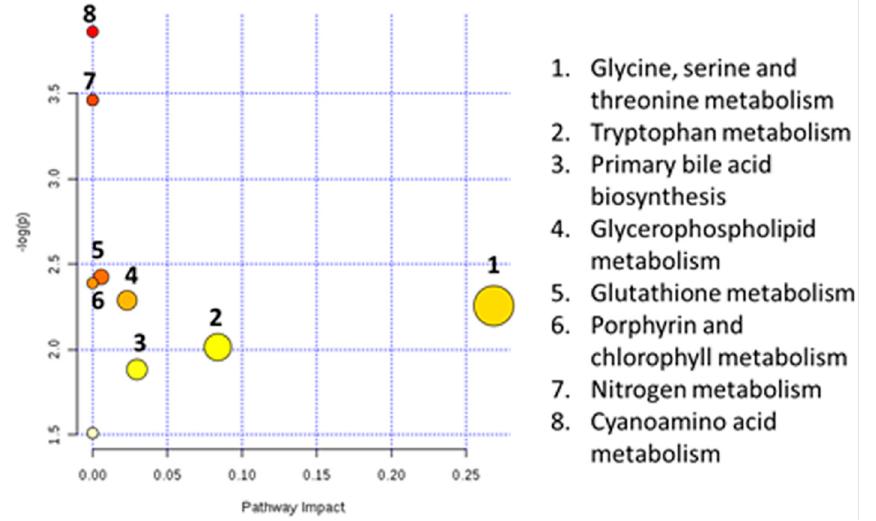
Figure 11. The metabolic pathways affected by NP exposure.